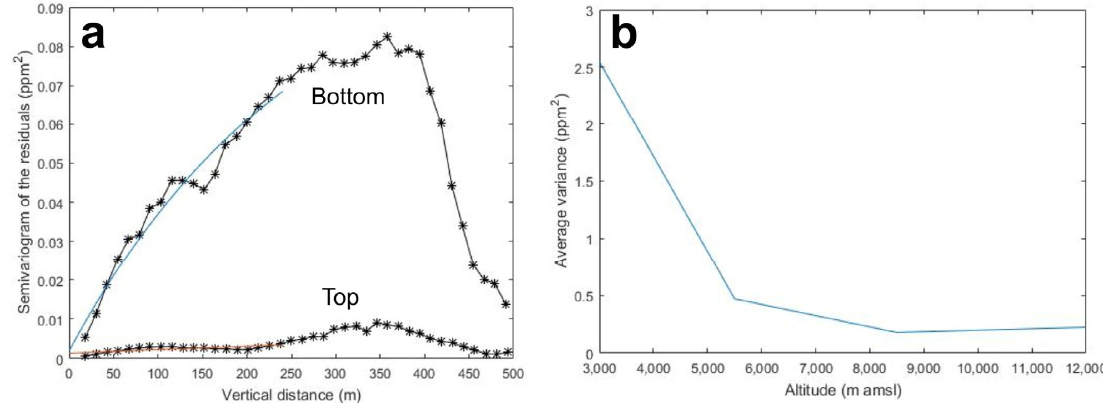
Figure 1. ( a ) Example variograms of the residuals at 200 and 8500 m altitude (window size ±500 m) for CO 2 (01/14/2012); ( b ) Height dependence of the average estimated variance for CO 2 of the residuals (window size ±500 m) for the entire dataset.